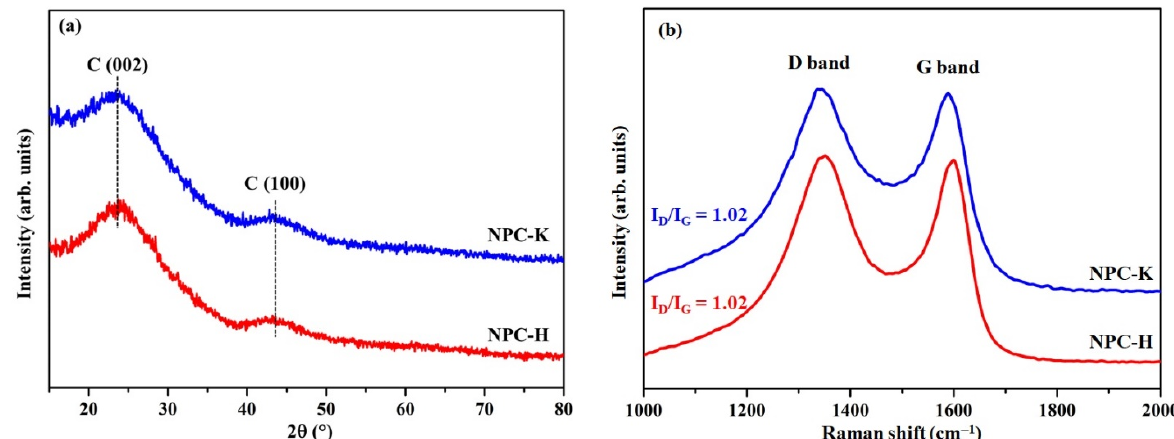
Figure 2. ( a ) XRD pattern and ( b ) Raman spectra with calculated ID/IG ratios of the NPC-K (blue curves) and NPC-H (red curves) samples.